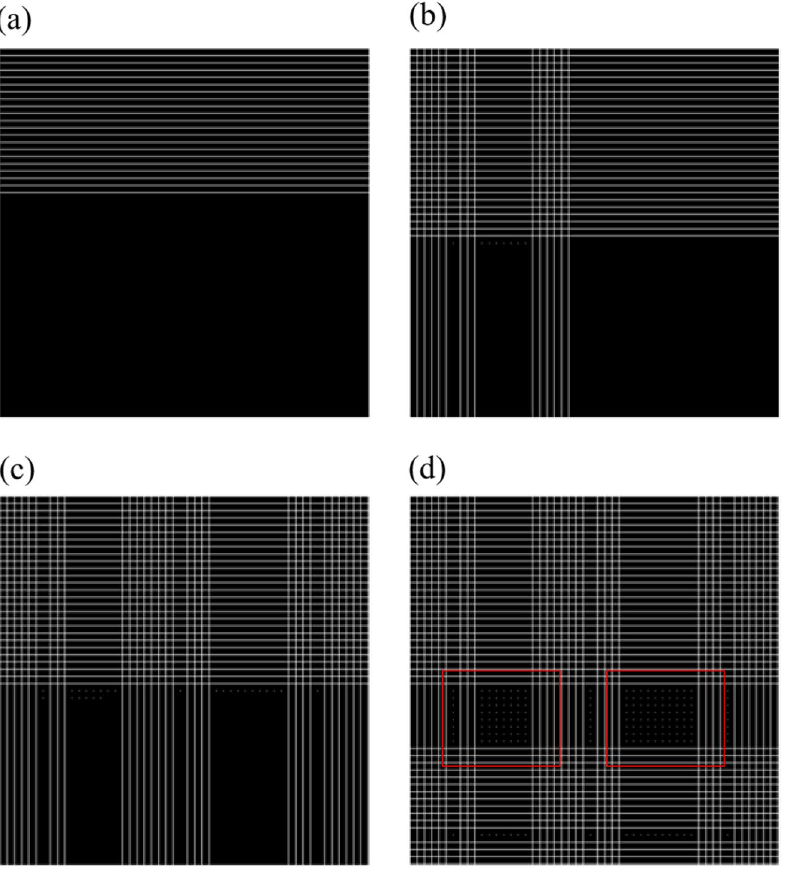
Figure 11. Visualization of the sequential steps of the kidney scan algorithm. White lines indicate areas already tested (or